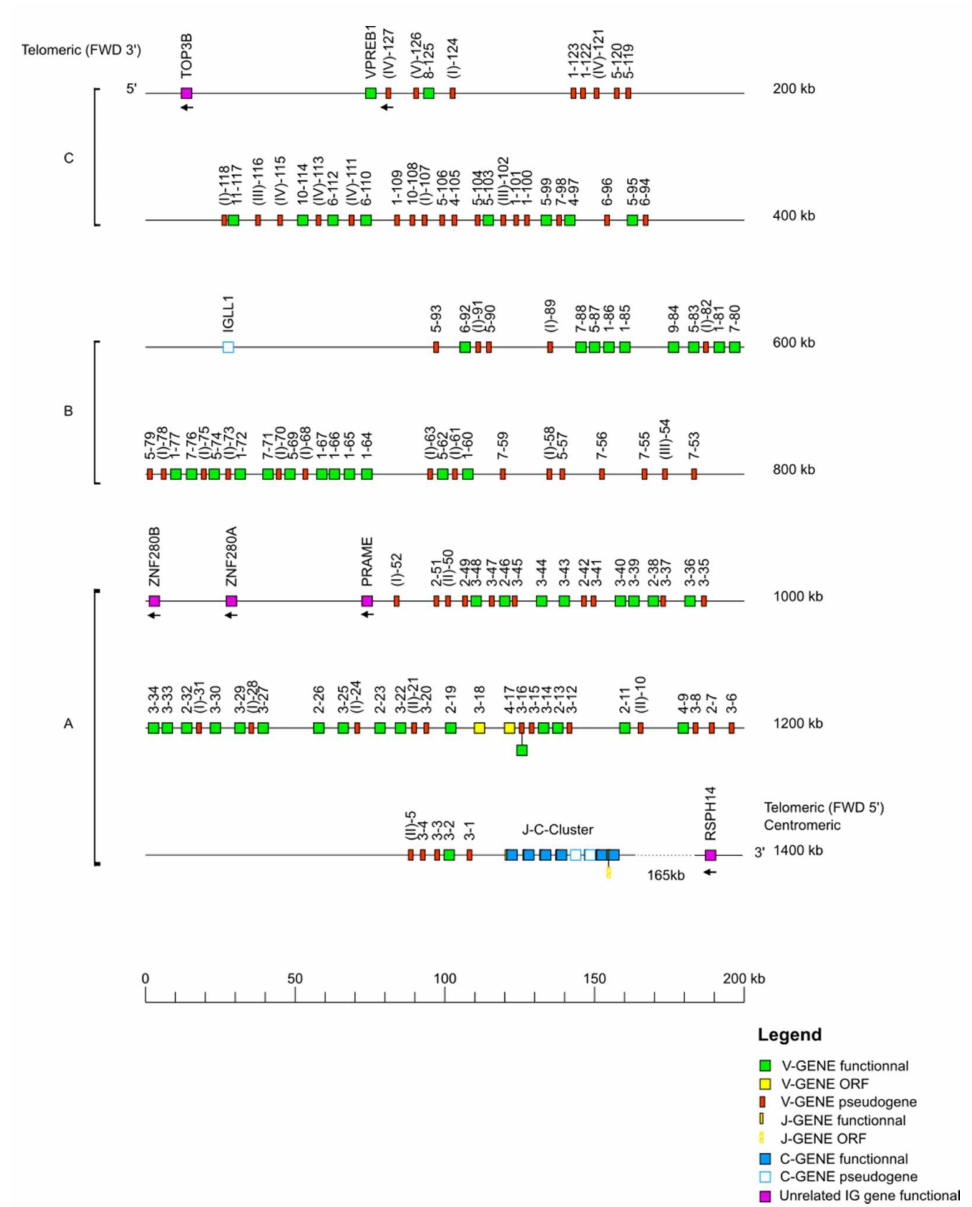
on the chromosome is REV. The IGL locus spans 1301 kb from 10 kb upstream of the most 5 (cid:48) gene (non-IG VPREB1 (F)), to 10 kb downstream of the most 3 (cid:48) gene (IGLC7 (F)). The locus representation (Figure 5) encompasses 1400 kb including the IMGT 5 (cid:48) borne (TOP3B) and the IMGT 3 (cid:48) borne (RSPH14).